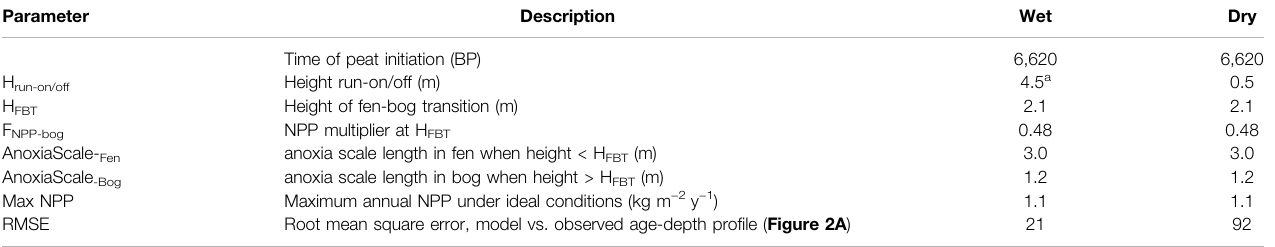
TABLE 1 | Model parameterization used in HPM-Arctic for the wet and dry landscape scenarios at Thelon-Kazan Peatland (TKP). Parameter